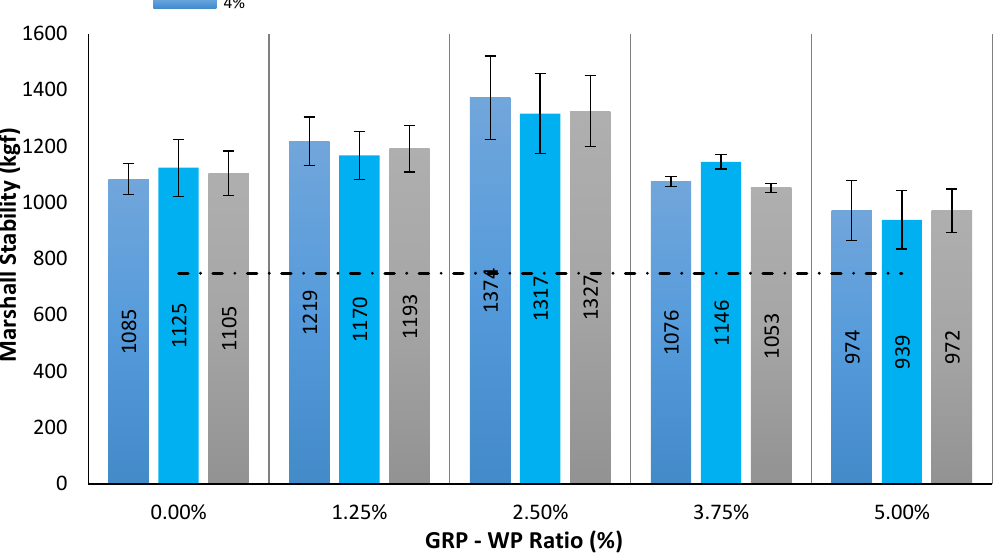
Figure 4. Comparison of MS results for the 45 samples tested.